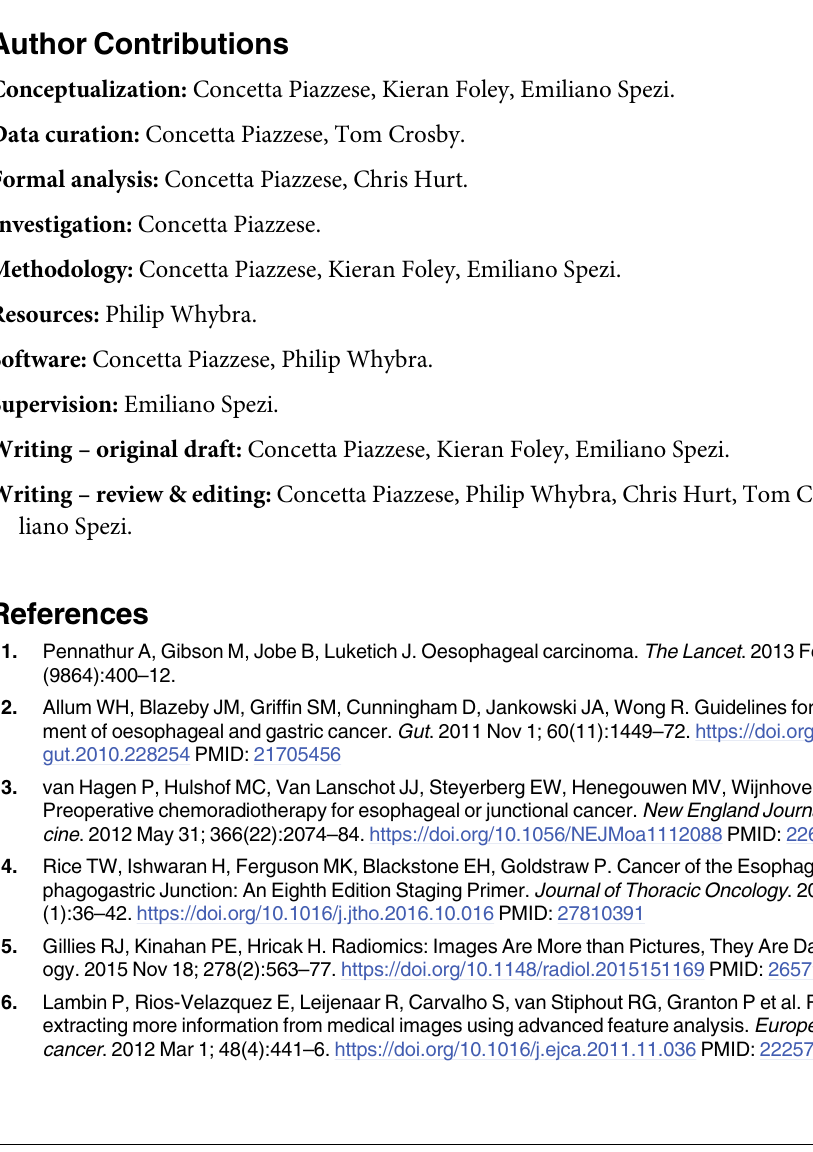
S1 Table. List of 2D and 3D radiomic features that showed to be stable when extracted from the mixed, the contrast and the non-contrast group. GLCM, grey level co-occurrence matrix; GLRLM, grey level run length matrix; GLSZM, grey level size zone matrix; GLDZM, grey level distance zone matrix; NGTDM, neighbourhood grey tone difference matrix; � , fea- ture computed with